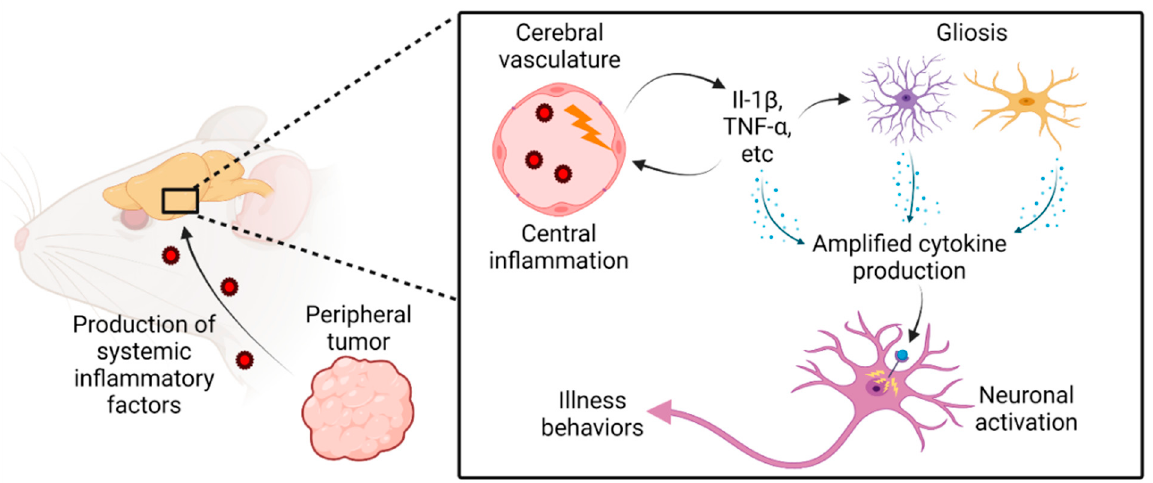
Figure 1. Model of CNS amplification of peripheral inflammatory signals during the evolution of cancer cachexia.